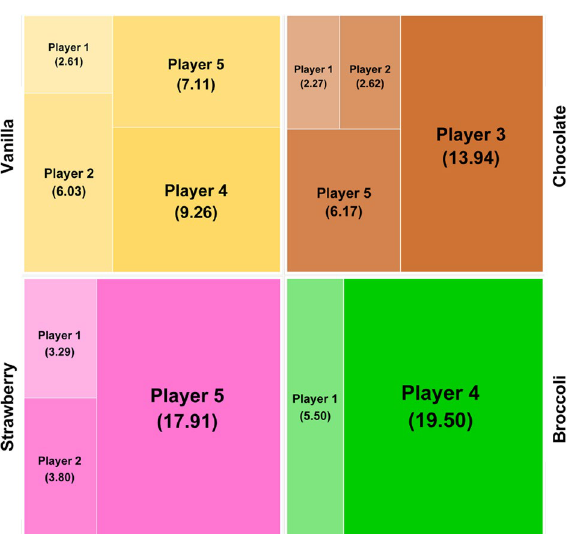
Figure 4. Heterogeneous cake-cutting using the weighted Boltzmann division. It is assumed that the whole cake (100%) has four flavors (vanilla, chocolate, strawberry, and broccoli) of equal size (25%). The vanilla and chocolate flavors are preferred by four players and thus shared by them. On the other hand, the least popular broccoli flavor is preferred by only two players; therefore, relatively large shares of the broccoli flavors are allocated to the two